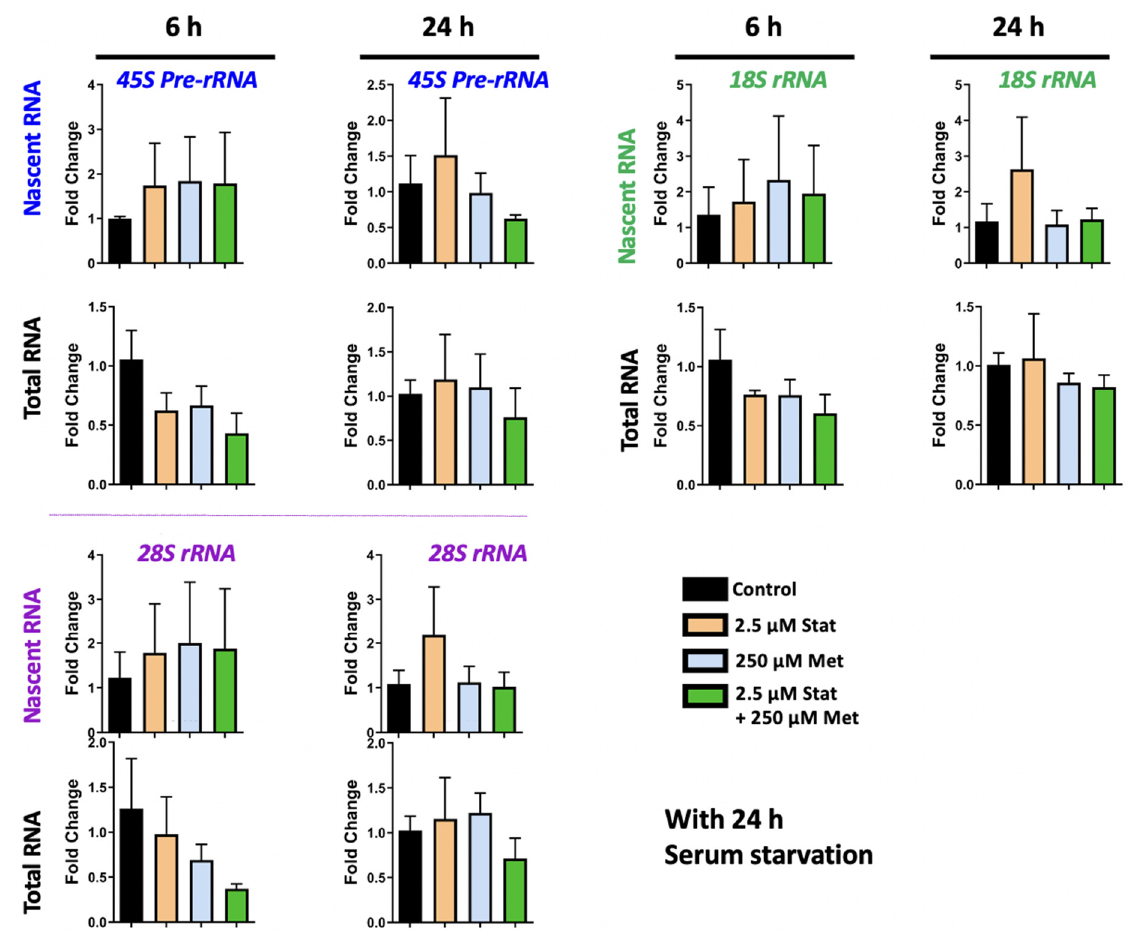
Figure 7. Combined transcriptional effect of simvastatin and metformin on ribosomal RNA genes with serum starvation. Daoy cells were serum-starved for 24 h prior to drug treatment with 2.5 µ M simvastatin (Stat), 250 µ M metformin (Met), and a combination of 2.5 µ M Stat + 250 µ M metformin. Samples were collected at 6 and 24 h and gene transcripts were analyzed by RT-PCR for 45S pre-rRNA , 28S rRNA , and 18S rRNA transcripts. C T values were normalized to the housekeeping gene GAPDH and fold change was determined relative to the average control. N = 3 ± SEM. Fold change values were analyzed by one-way ANOVA followed by Tukey’s multiple comparisons test.